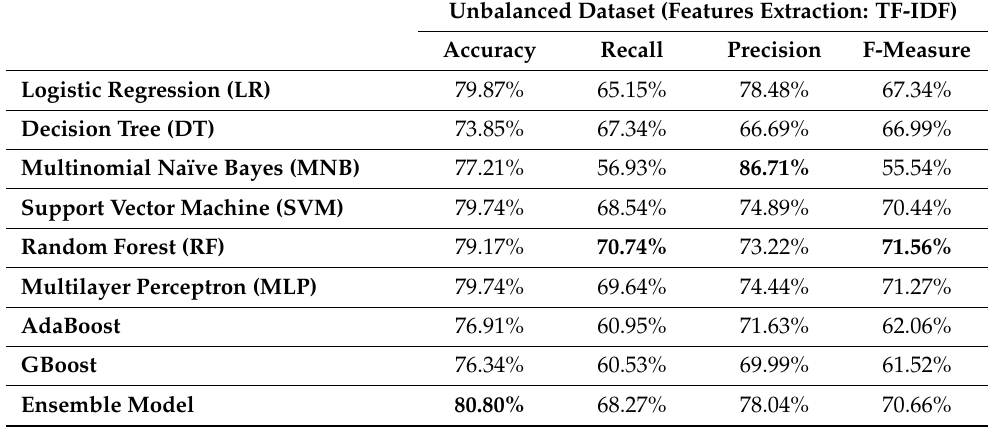
Table 6. Classification results for sentiment analysis of unbalanced dataset.